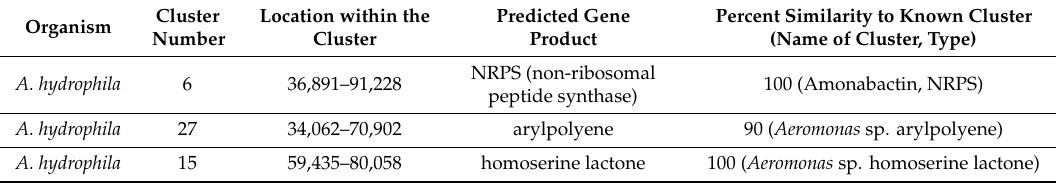
Table 5. Antibiotics and Secondary Metabolites Analysis Shell (antiSMASH) prediction of biosynthetic gene clusters involved in the synthesis of antibiotics and secondary metabolites in A. hydrophila and C.